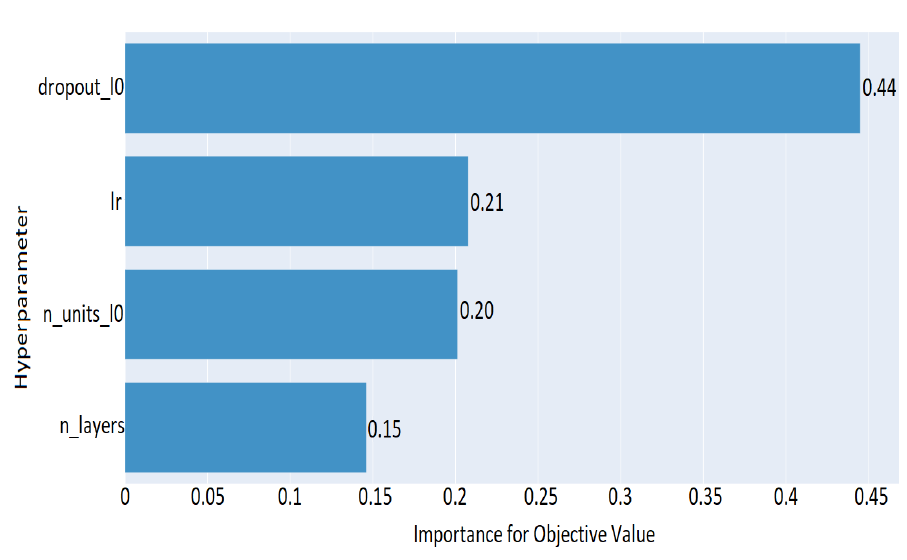
Figure 7. Hyperparameters’ importance for the DNN